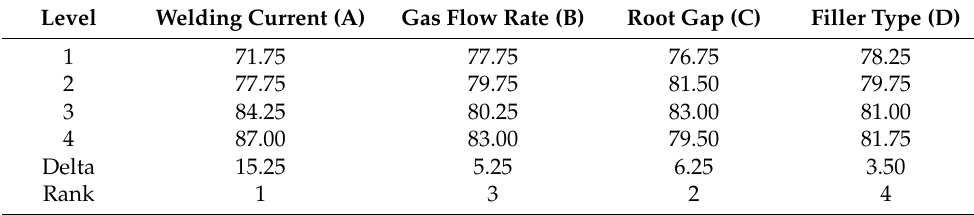
Table 12. Response table for means of Hardness.